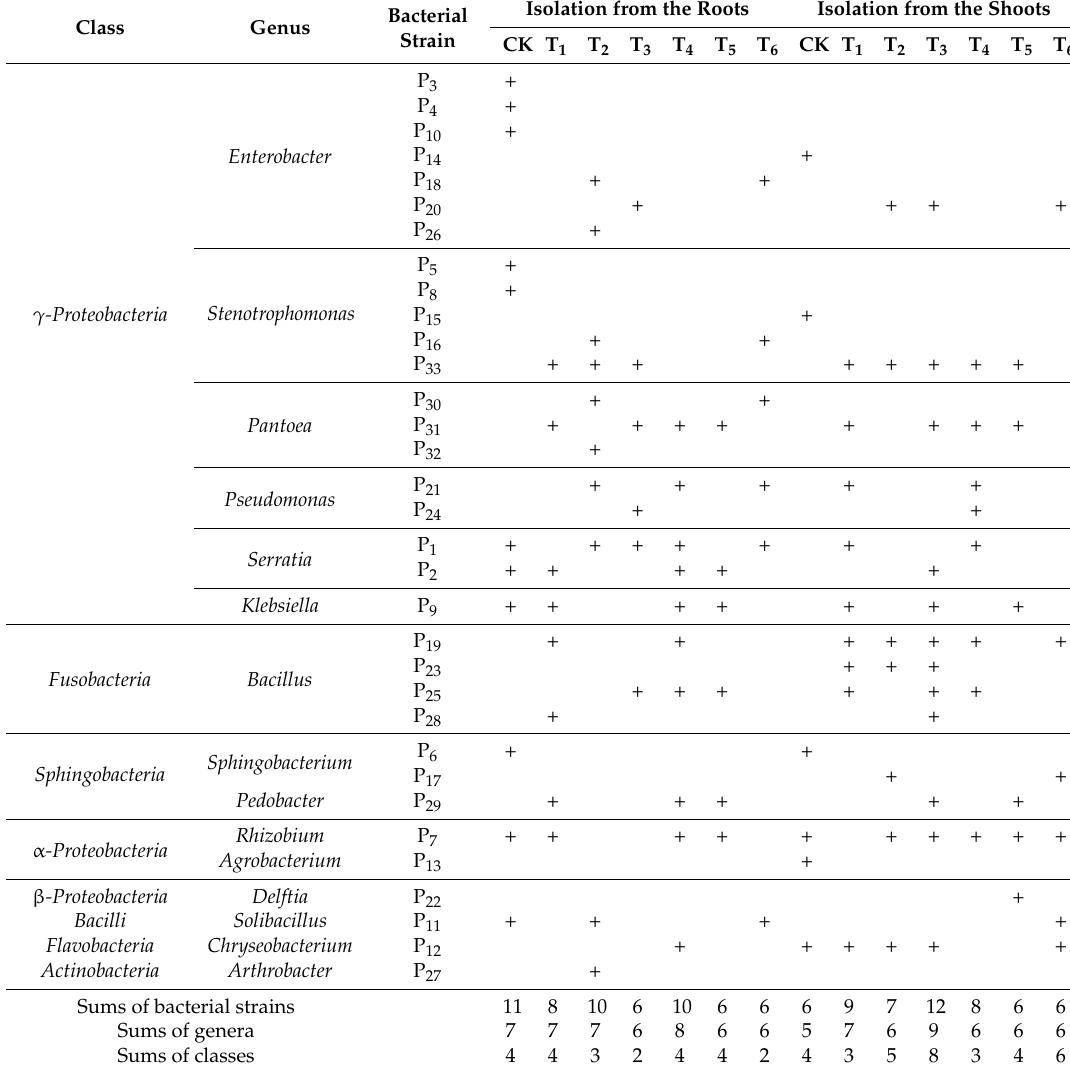
Table 3. Cultivable endophytic bacterial strains isolated from the seedlings from all groups.